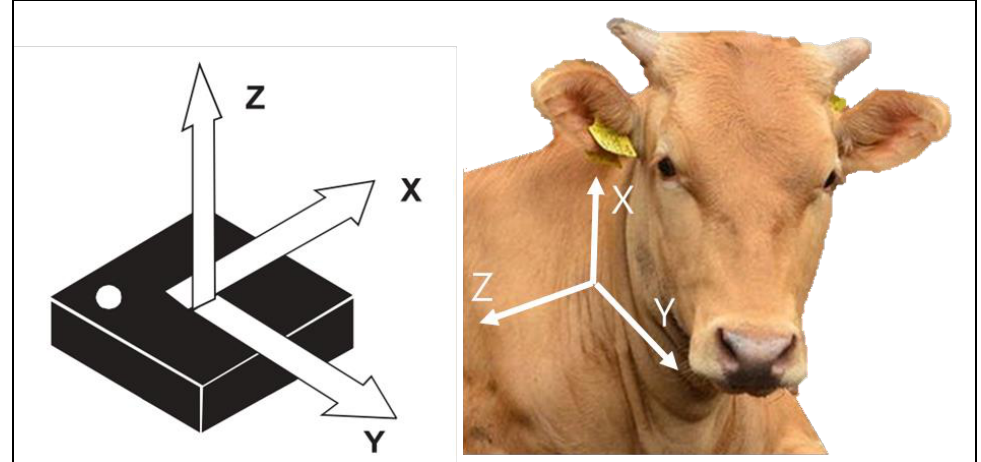
Figure 2. Orientation of the sensor in the Korean steer. The left figure showed the directions of the detectable accelerations on top view. The figure on the right shows the directions of the detectable accelerations when the sensor is positioned on the right neck side of the cattle. The x -axis measured the vertical movements of the head of the cattle, the y -axis measured the horizontal movements of the head of the cattle, and the z -axis measured the lateral, sideways, or rotational movements of the head of the cattle.